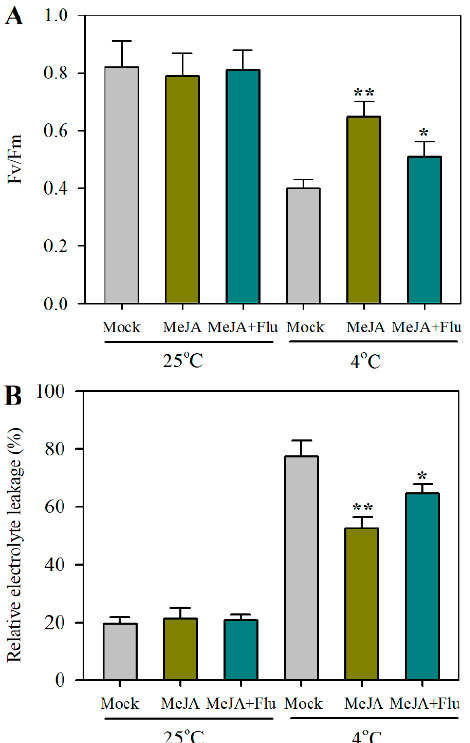
Figure 4. ABA contributes to JA-induced cold tolerance in tomato. ( A ) Changes in Fv/Fm as affected by MeJA and the ABA biosynthesis inhibitor fluridone (Flu) under cold conditions. ( B ) Changes in relative electrolyte leakage as affected by MeJA and the ABA biosynthesis inhibitor fluridone (Flu) under cold conditions. Tomato plants at the 4-leaf stage were treated by MeJA and Flu 12 h prior to cold stress at 4 °C for 24 h. Cold tolerance was assessed by determining Fv/Fm and relative electrolyte leakage. Data presented are means of three biological replicates ( ± SD). Asterisks indicate significant differences (** p < 0.01, * p < 0.05) according to Student’s t -test.